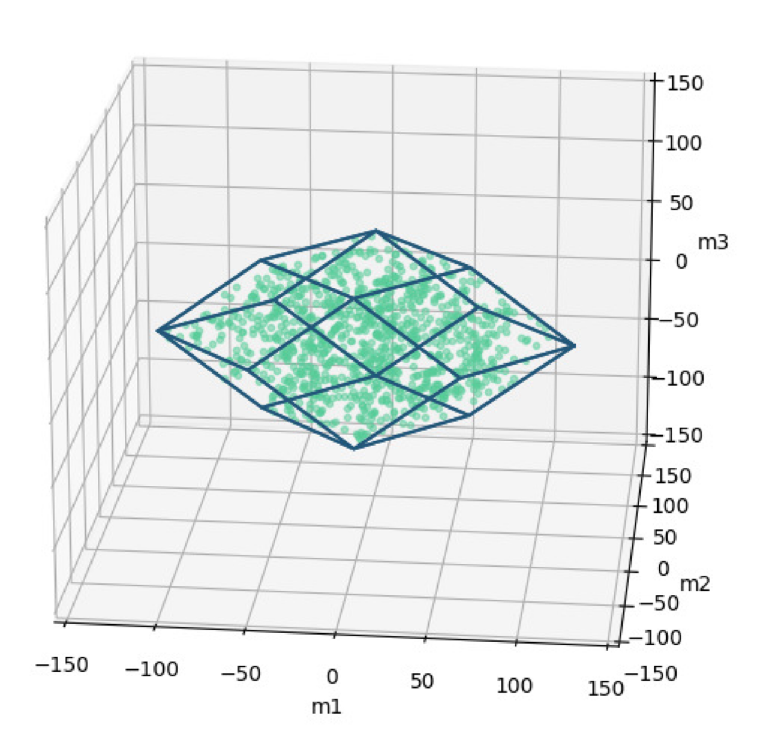
Figure 6 . Numerical analysis of duality cascades. The green dots denote the endpoints of duality cascades obtained from various initial brane configurations and the blue lines form the fundamental domain of the rhombic dodecahedron studied in figure